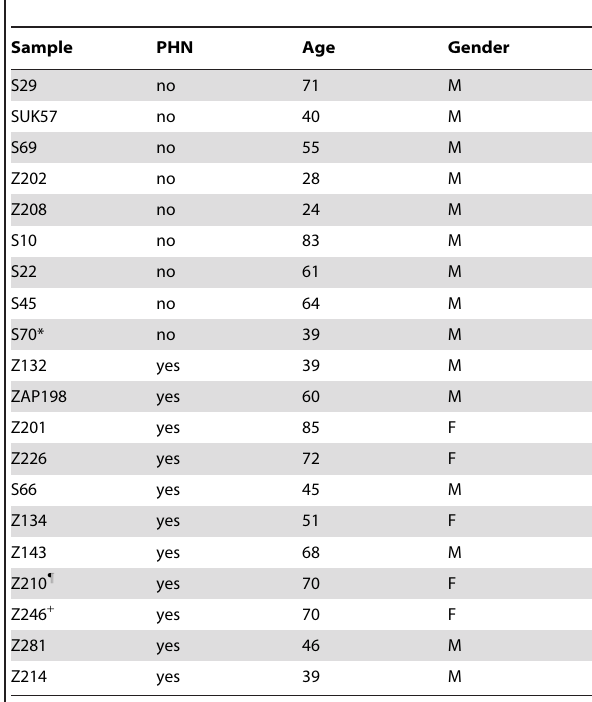
Table 1. Post herpetic neuralgia (PHN)-associated and non- PHN associated viruses used in